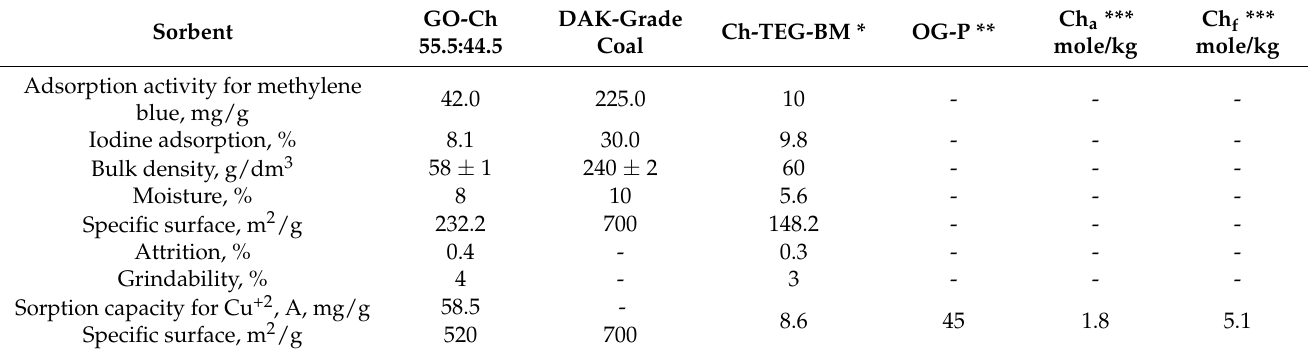
Table 4. Characteristics of GO-Ch composite (sample No. 4) and DAK-grade